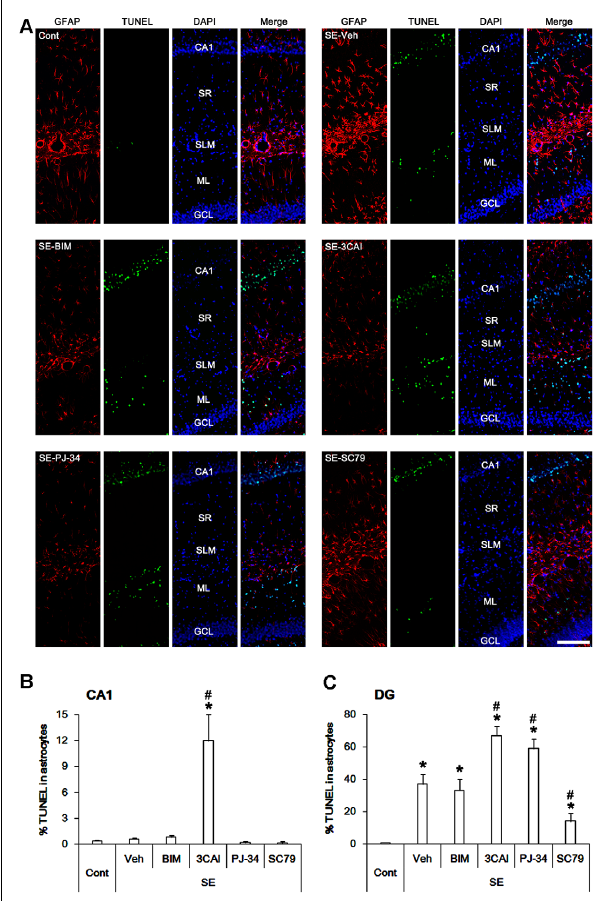
FIGURE 6 | Astroglial apoptosis in the hippocampus following SE. SE does not induce apoptosis in CA1 astrocytes. 3CAI leads to CA1 astroglial apoptosis following SE. However, SE result in apoptotic degeneration in dentate astrocytes, which is deteriorated by 3CAI and PJ-34. SC79 ameliorates dentate astroglial apoptosis following SE. (A) Representative immunofluorescent images for GFAP and TUNEL following SE. (B,C) Quantification of the percentage of TUNEL positive astrocytes in CA1 astrocytes (B) and dentate astrocytes (C) . Error bars indicate SEM ( ∗ , # p < 0.05 vs. control- and vehicle-treated animals, respectively; n = 7, respectively).